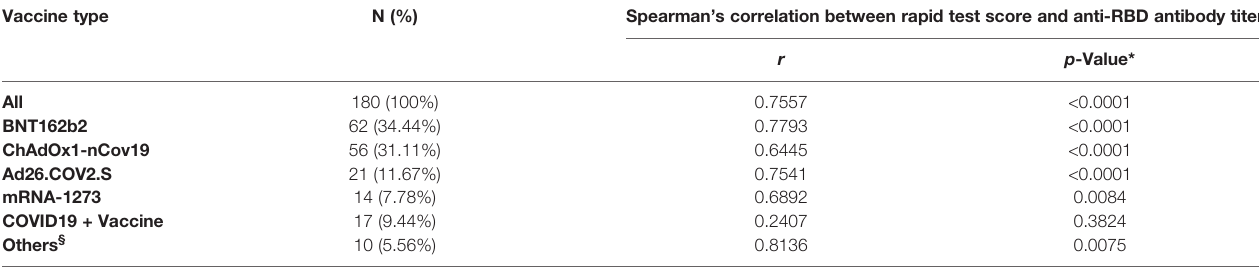
TABLE 4 | Spearman ’ s correlation between rapid test score and anti-RBD antibody titers in individuals who received different vaccines. Vaccine type N (%) Spearman ’ s correlation between rapid test score and anti-RBD antibody titer